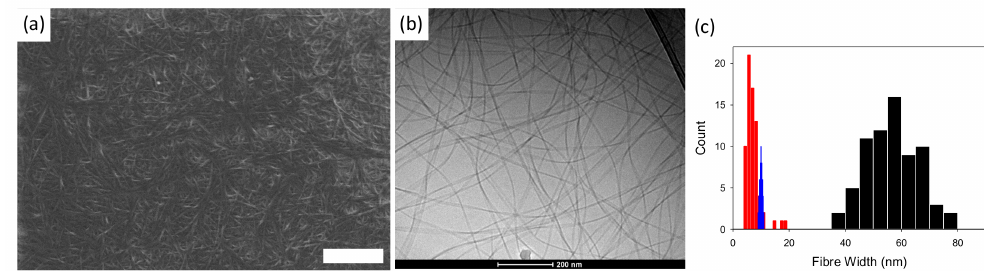
Figure 2. ( a ) SEM image of an air-dried xerogel of a dipeptide-based low molecular weight gel; ( b ) Cryo-TEM of the gel prior to drying; ( c ) Histogram of the widths of fibers measured from the SEM images (black) and cryo-TEM (red), along with the distribution expected from a Gaussian distribution (generated from SigmaPlot with a standard deviation of 0.4) around the mean diameter determined by SANS (blue). The data are re-drawn from those shown in reference